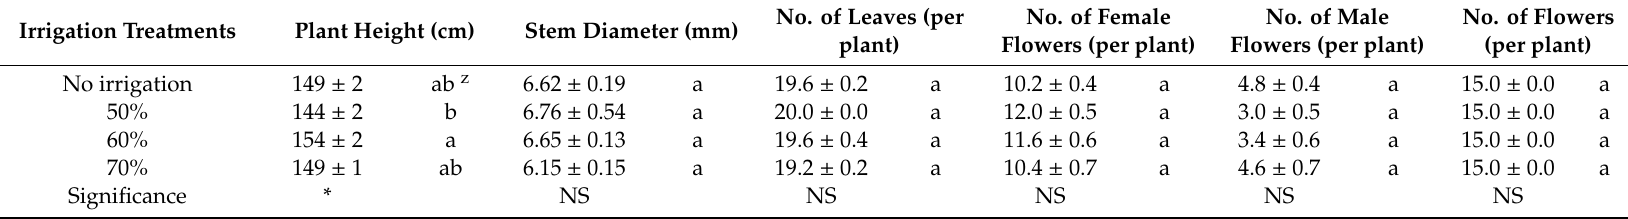
Table 4. Growth and development of grafted cucumber seedlings after transplanting as a ff ected by di ff erent irrigation regimens during the cultivation of scions and rootstocks in a PFAL ( n =